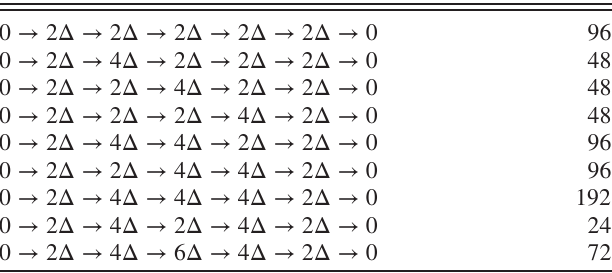
TABLE II. Possible routes the excitation energy above the ground state can take (left column), together with their respective multiplicities (right column). Note that the number of multiplic- ities adds up to 6! ¼ 720 .